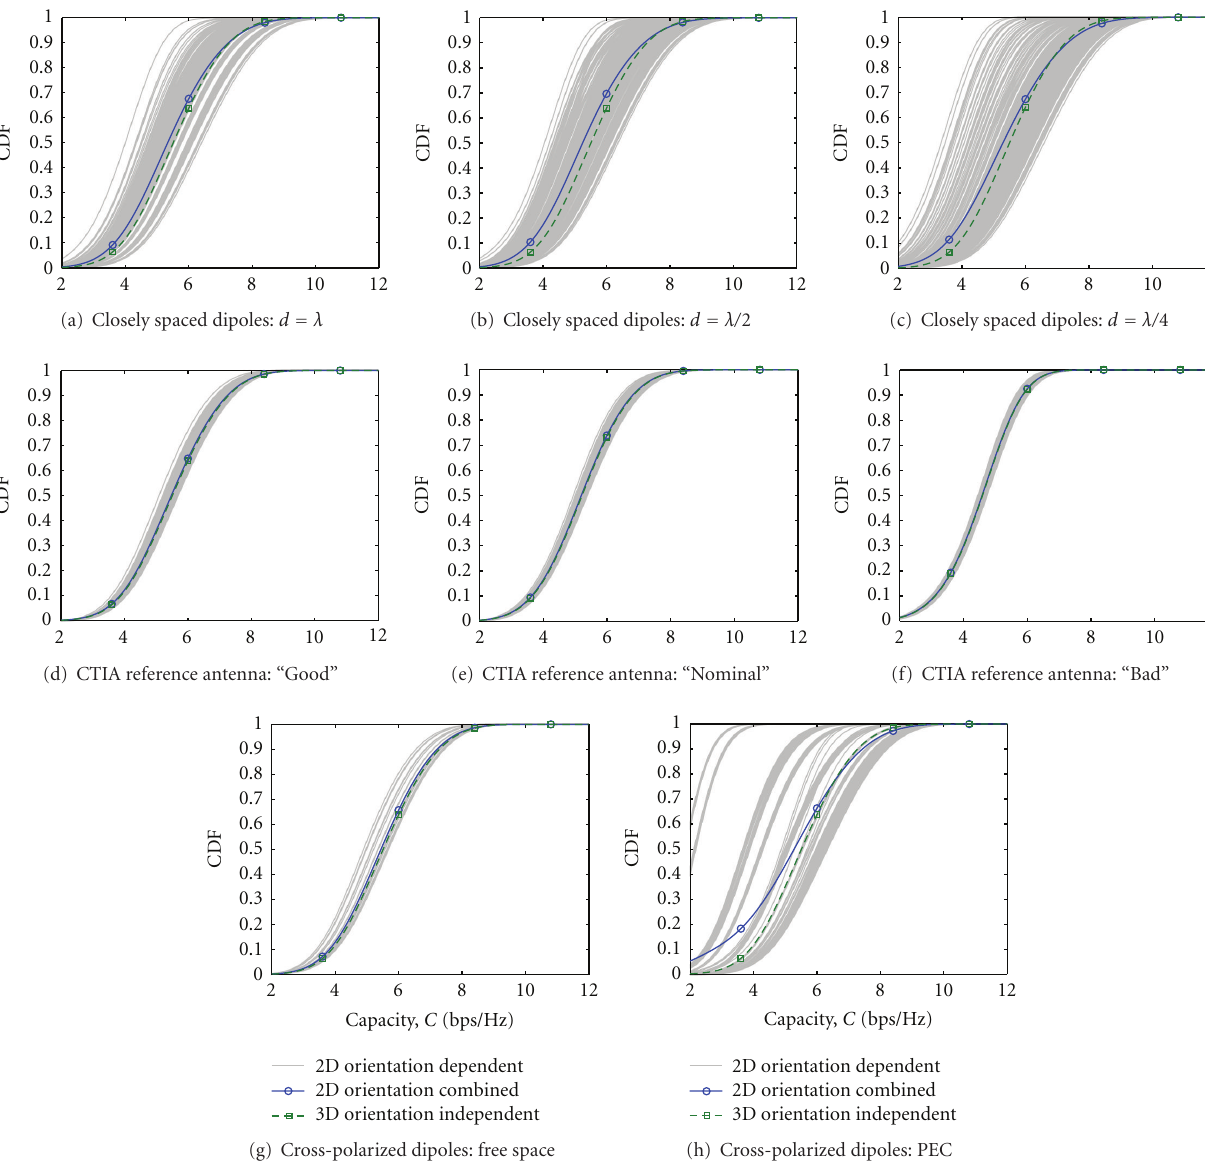
Figure 3: Comparison of the capacity CDFs for multiple orientations of the two-element antennas in statistically isotropic environments. Each plot compares the 2D environment’s orientation-dependent capacity CDFs, the 2D environment’s orientation-combined capacity CDFs, and the 3D environment’s orientation-independent capacity